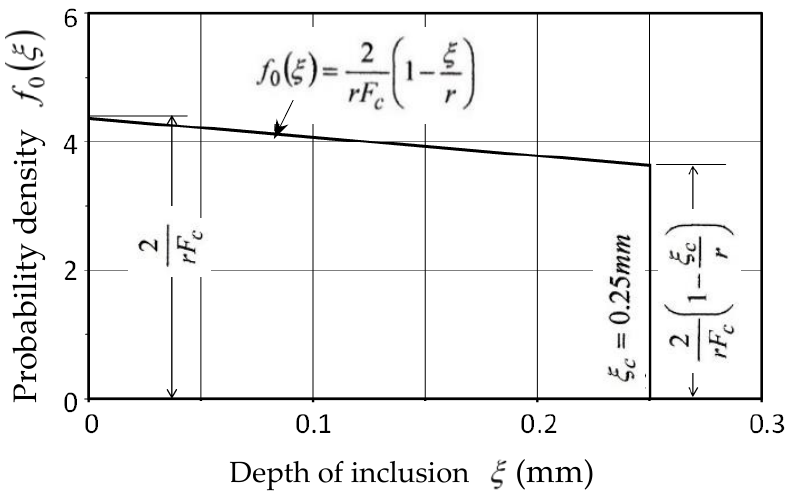
Figure 6. Probability function of inclusion depth f 0 ( ξ )